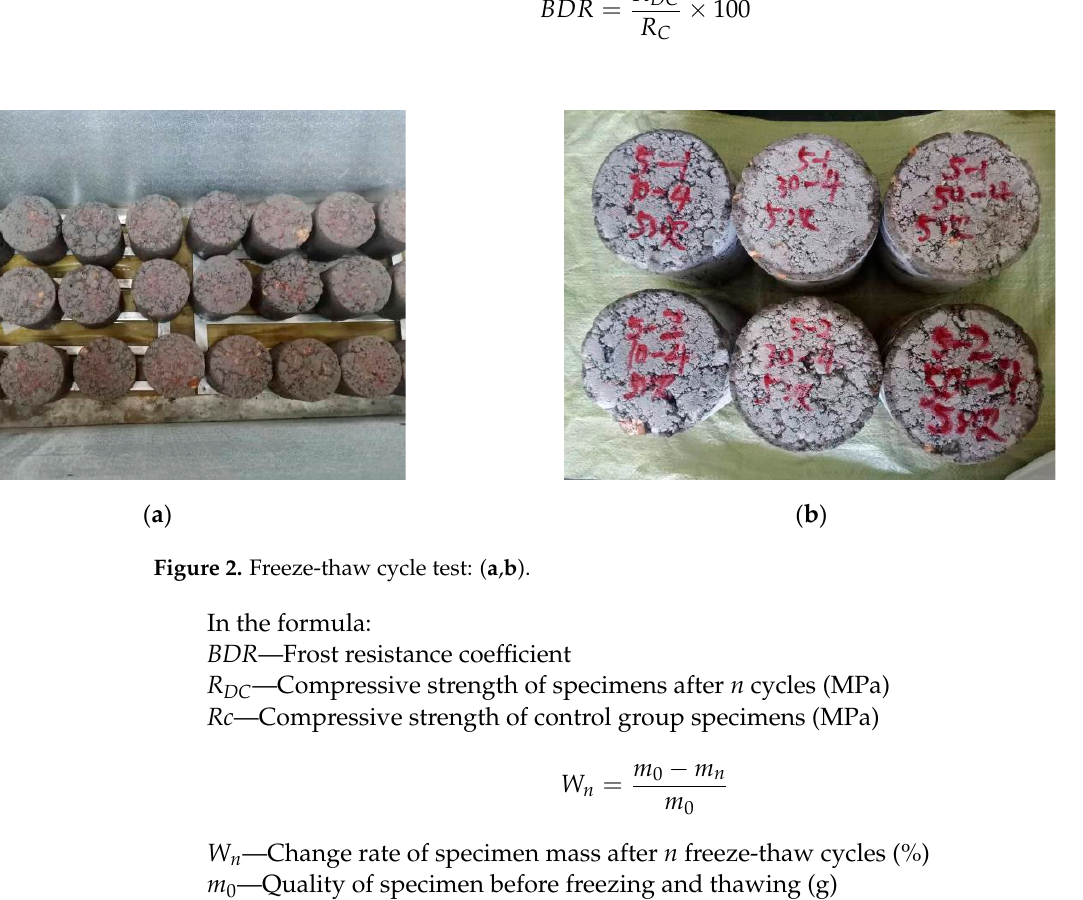
( b ) Figure 3. Relationship between temperature shrinkage coefficient and temperature range: ( a ) Vertical temperature shrinkage, ( b ) Circumferential temperature shrinkage. According to the results of the temperature shrinkage test, the mixtures with the five different mixing ratios exhibited the same trend over the same temperature range, in that the temperature shrinkage coefficient first increased and then decreased as the temperature was decreased. Within the temperature range of 10–60 °C, the temperature shrinkage coefficient increased as the temperature decreased. The temperature shrinkage 60~50 50~40 40~30 30~20 20~10 10~0 0~-10-10~-20 4 56789 101112 1314